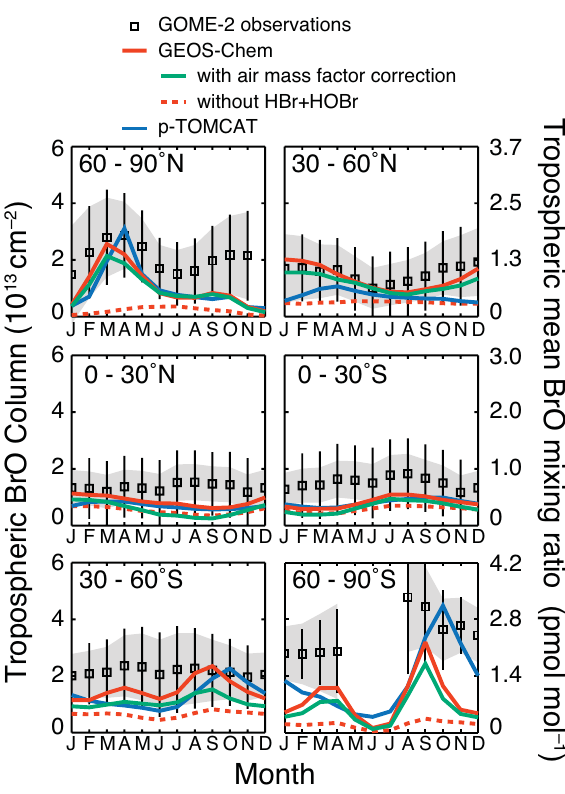
Fig. 5. Seasonal variation of mean tropospheric BrO columns in different latitudinal bands. GOME-2 observations from Theys et al. (2011) are compared to model values from GEOS-Chem and from p-TOMCAT (Yang et al., 2010). GEOS-Chem values are shown for the actual vertical columns (red) and for vertical columns corrected by the GOME-2 air mass factors (green). Also shown are results from a sensitivity simulation without the HBr+HOBr het- erogeneous Reaction (R30). p-TOMCAT values are actual vertical columns. The models were sampled at 09:00–11:00local time (LT), corresponding to the GOME-2 viewing time of ∼ 09:30LT. Grey shading shows the observational error on the means reported by Theys et al. (2011) and vertical bars indicate one standard devia- tion of their spatial averaging. The BrO mixing ratios on the right axis scale are derived from the BrO columns by dividing by the an- nual mean tropospheric air density columns for the corresponding latitude bin in